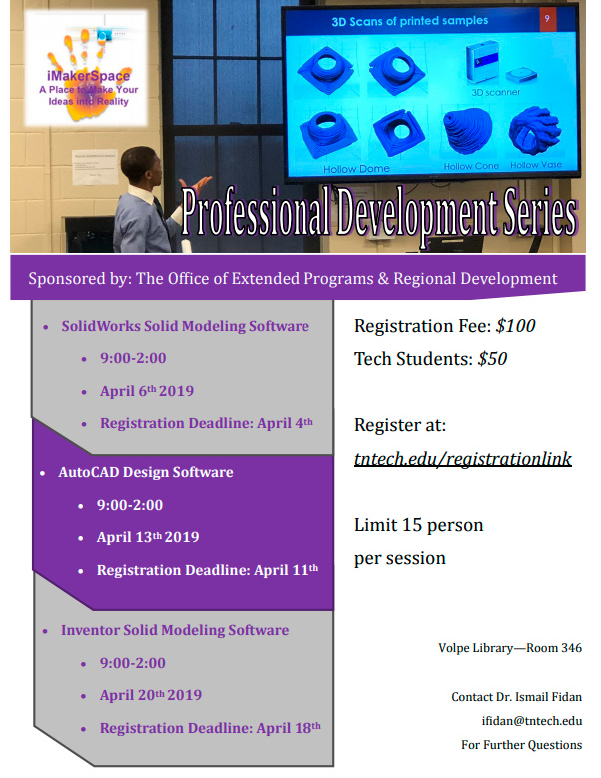
Figure 5. Computer Aided Design Workshops offered in Summer 2019 .